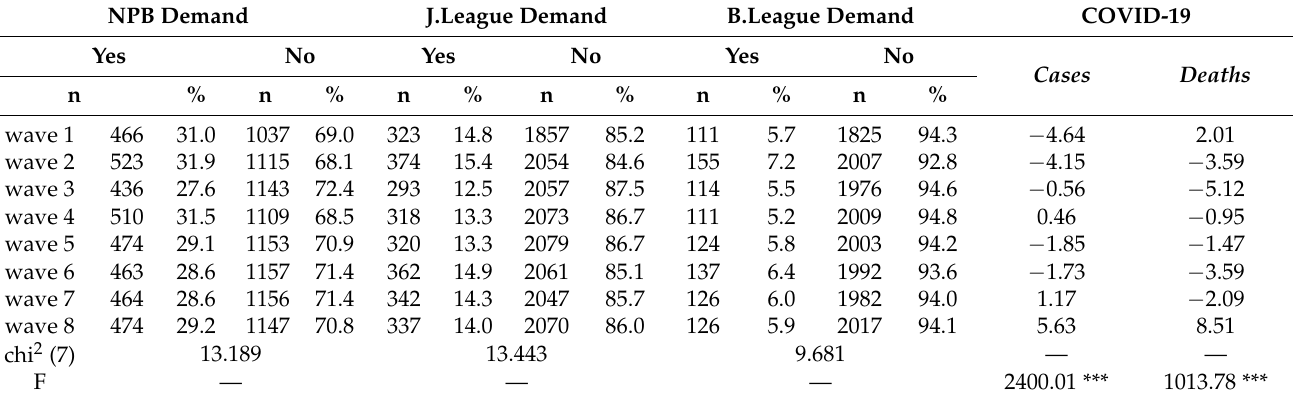
Table 2. Changes in spectator demand and COVID-19 infection status between survey